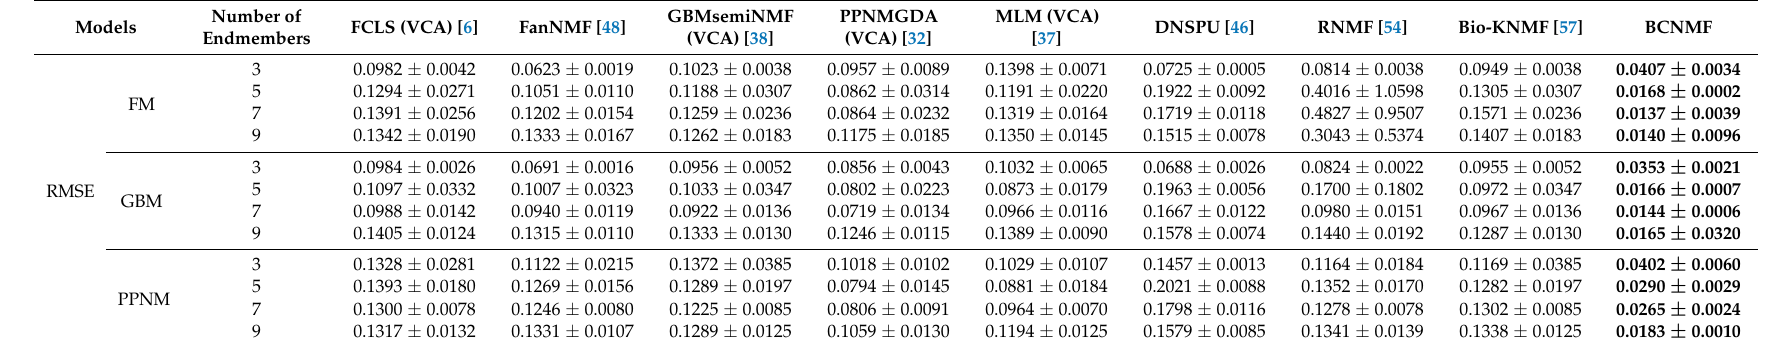
Table 5. RMSEs of all algorithms with different numbers of endmembers.